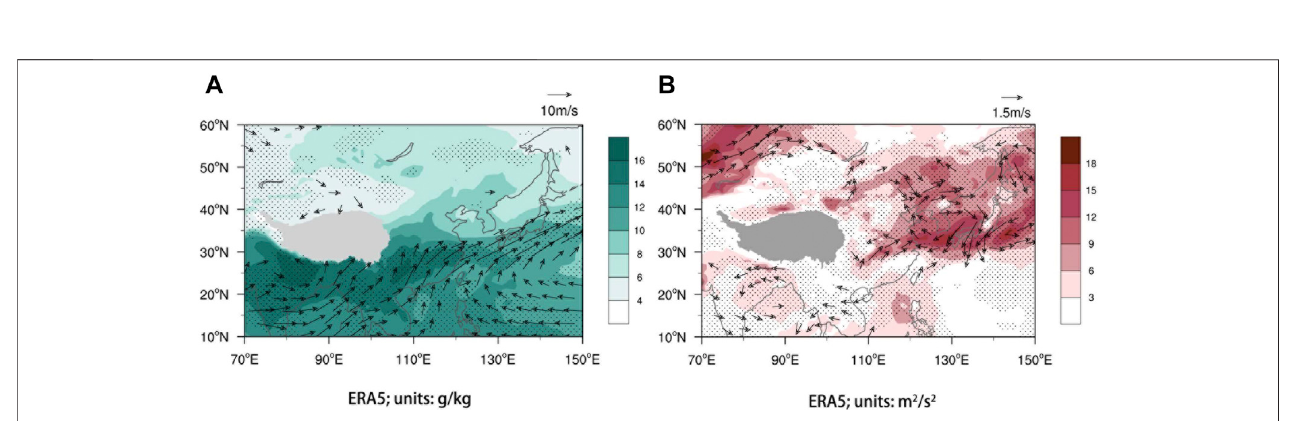
FIGURE 12 | As in Figure 5 but for the composites of 2020